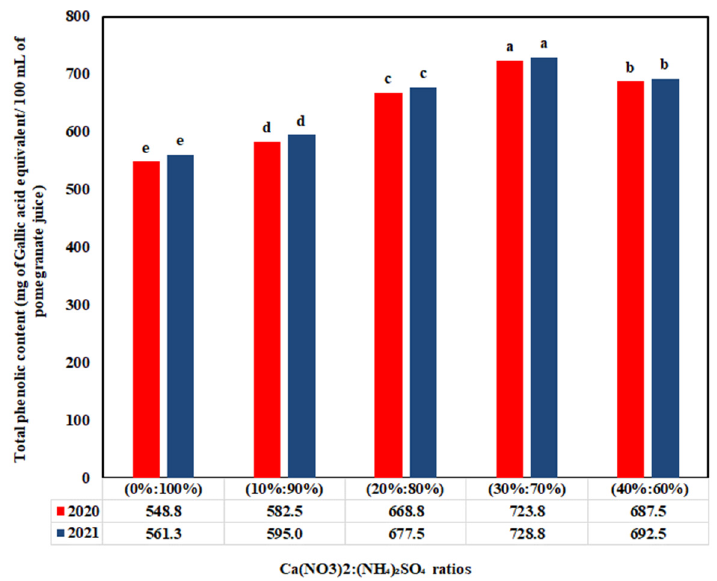
Figure 4. The impact of Ca(NO 3 ) 2 :(NH 4 ) 2 SO 4 ratios on total phenolic content of the pomegranate fruits of cv. ‘Wonderful’ in 2020 and 2021 seasons. Significant differences ( p < 0.05) are denoted by values in the same column that are marked with distinct letters.